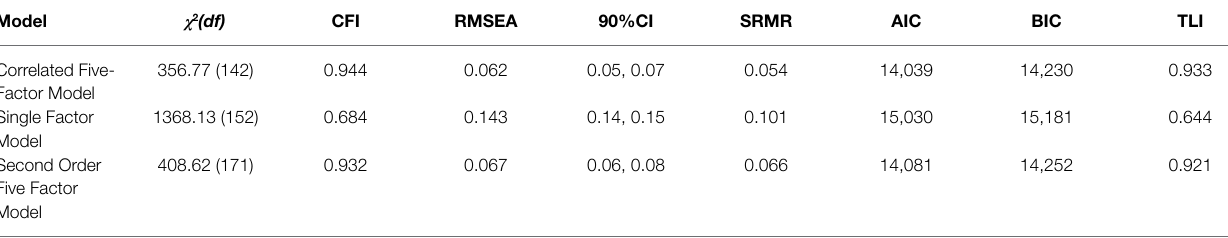
TABLE 2 | Confirmatory Factor Analyses in Study